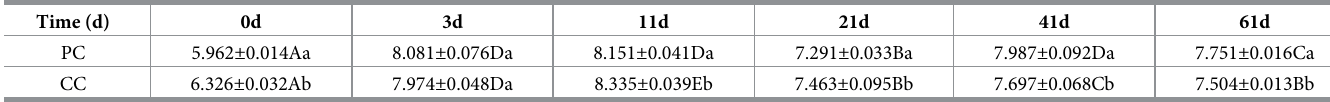
Data in the table were the mean ± S.D. of three fermented sausage per experimental group of three independent experiments. Different capital letters indicated significant differences over time within the same group ( P < 0.05) and different lowercase letters indicated significant differences between groups at the same time ( P < 0.05), while the same letter indicated no significant difference ( P > 0.05).